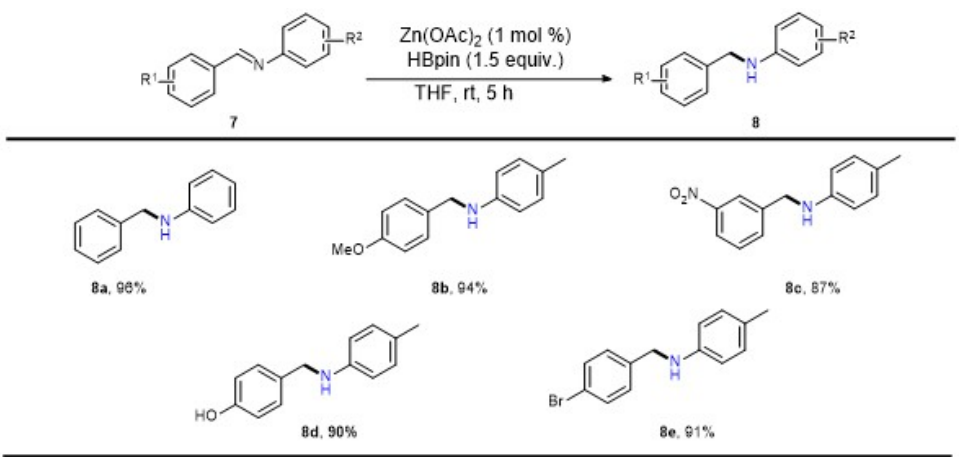
Figure 1. Kinetic profiles for Zn-catalyzed reduction of 1a : ( a ) reaction profile of Zn-catalyzed reduction of 2-naphthaldehyde, ( b ) initial reaction rate against the concentration of 1a , ( c ) initial